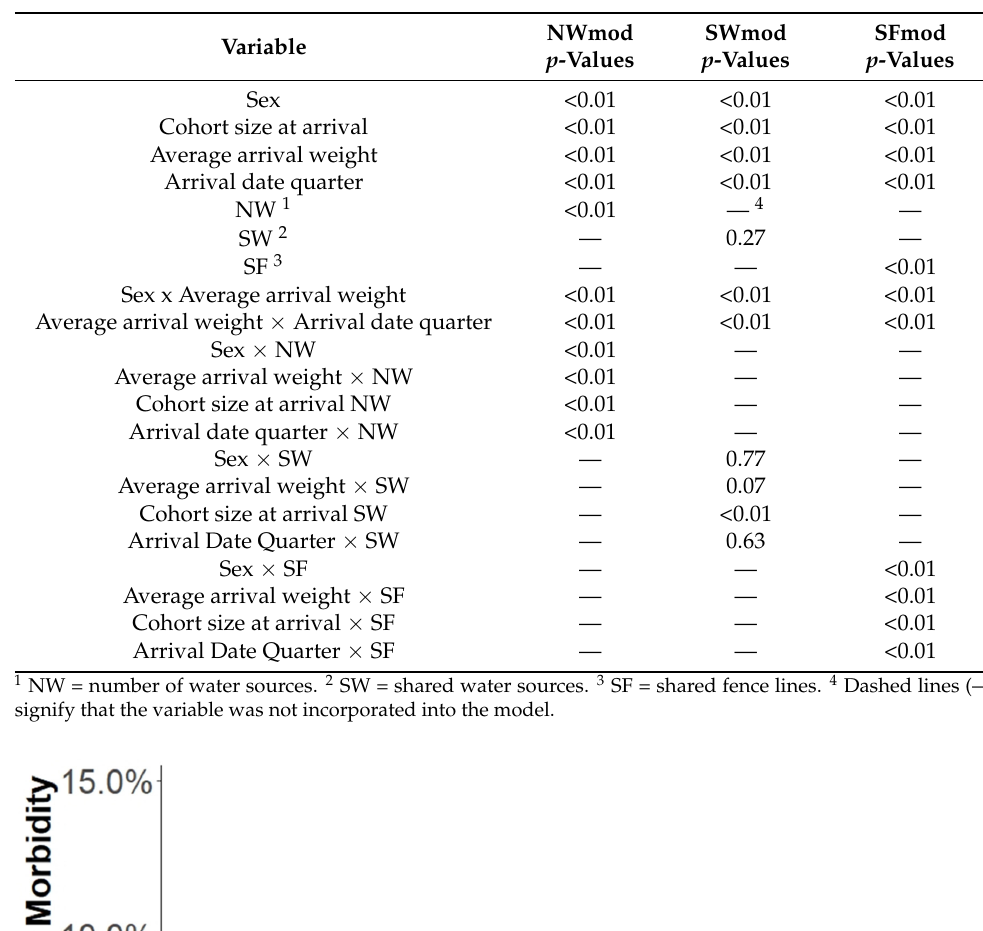
Table 3. Final generalized linear mixed-models demonstrating housing characteristics and cattle demographic factors and their association with bovine respiratory disease incidence during the first 45 DOF. Data were included from 10 United States feedlots from 2018–2020. Three models (NWmod, SWmod, SFmod) for each hosing factor (number of waters, shared waters, and shared fence lines) were evaluated.